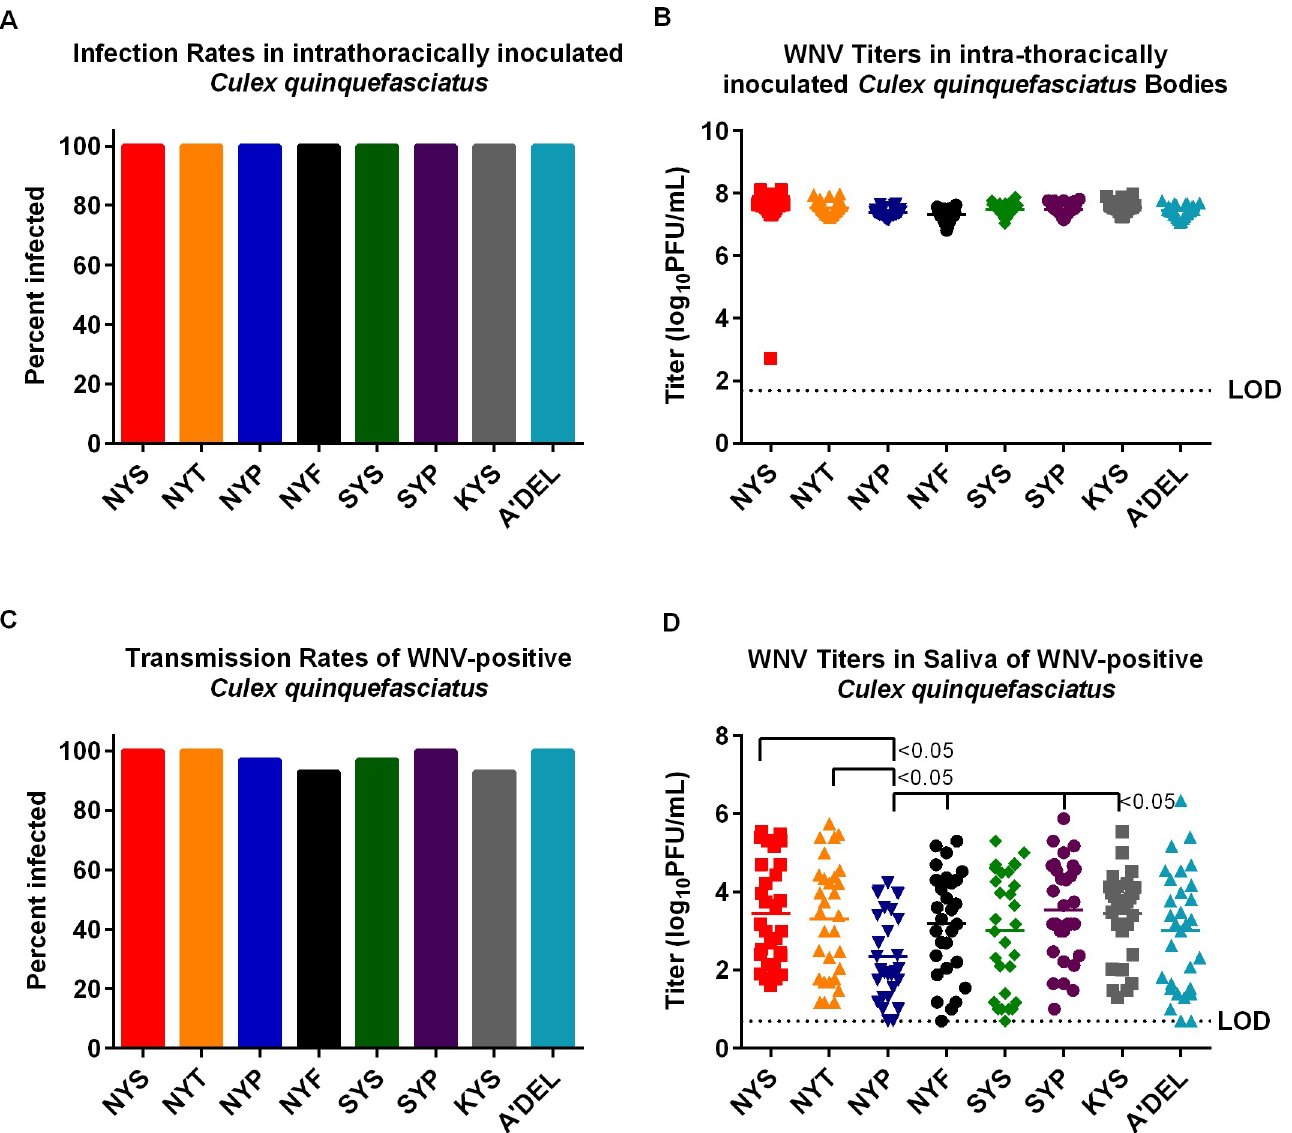
Fig 6. Viral growth in Culex quinquefasciatus intrathoracically inoculated with WNV glycosylation mutant viruses. Culex quinquefasciatus were intrathoracically inoculated with 0.14 μ L of 6 log 10 PFU/mL of WNV parental and WNV glycosylation mutant viruses (NYT, NYP, NYF, SYS, SYP, KYS, and A’DEL). After an extrinsic incubation period of 7 days, bodies and saliva were collected from 25 mosquitoes, mixed with diluent, homogenized and titrated by standard plaque assay. Figures demonstrate (A) infection rate (%) in Cx . quinquefasciatus bodies (B) viral titers in Cx . quinquefasciatus bodies in log 10 PFU/mL (C) transmission rate (%) in Cx . quinquefasciatus saliva (D) viral titers in Cx . quinquefasciatus saliva in log 10 PFU/mL. Mean viral titers were analyzed via a one- way ANOVA. Infection and transmission rates were analyzed using a pairwise Fisher’s exact test. Limit of detection (LOD) is shown by dashed